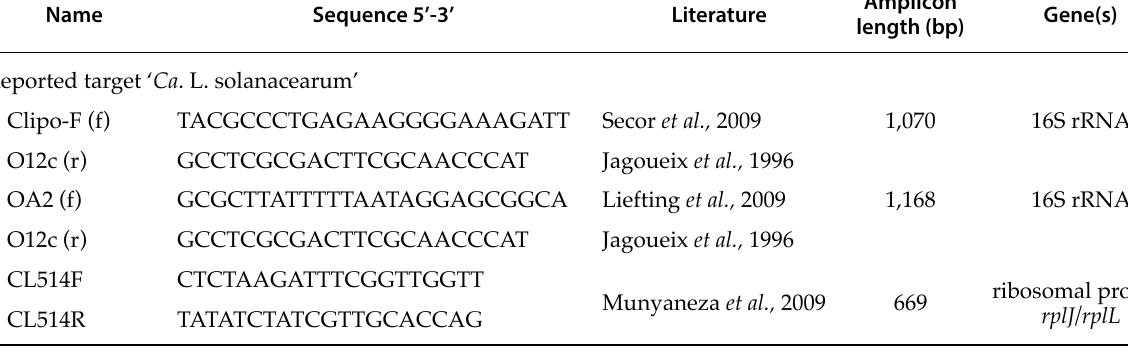
TATATCTATCGTTGCACCAG Reported target ‘ Ca . Phytoplasma’